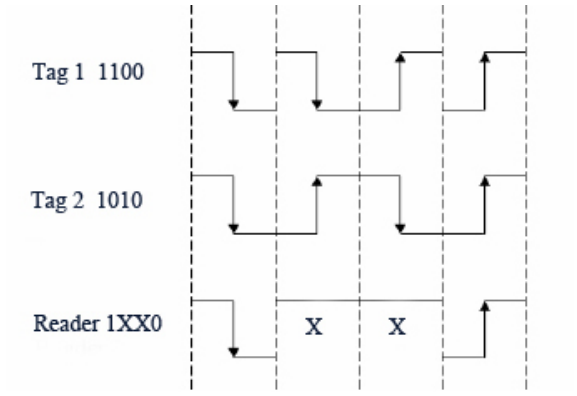
Figure 18. Example of Manchester codification showing a collision at the 2nd and the 3rd bits.